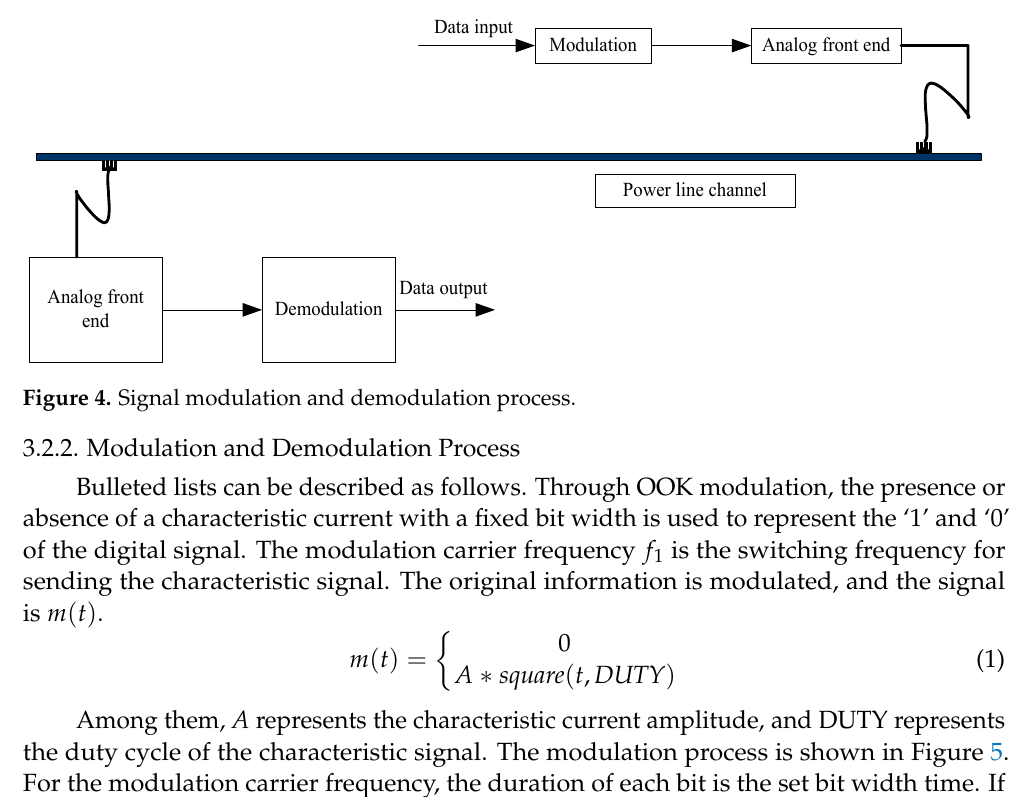
Figure 4. Signal modulation and demodulation process.